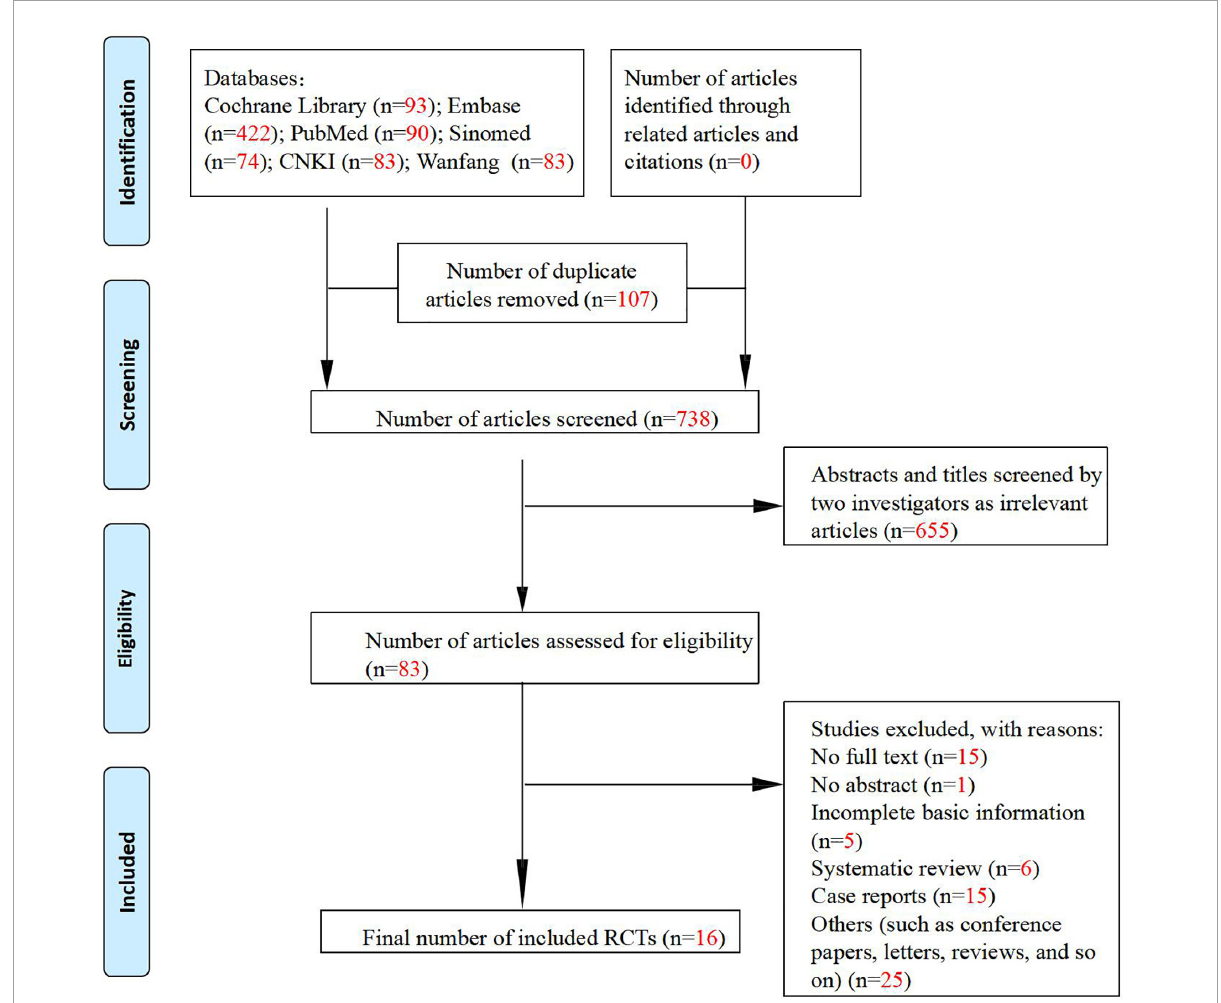
FIGURE1 Flowchart of study inclusion according to the PRISMA 2009